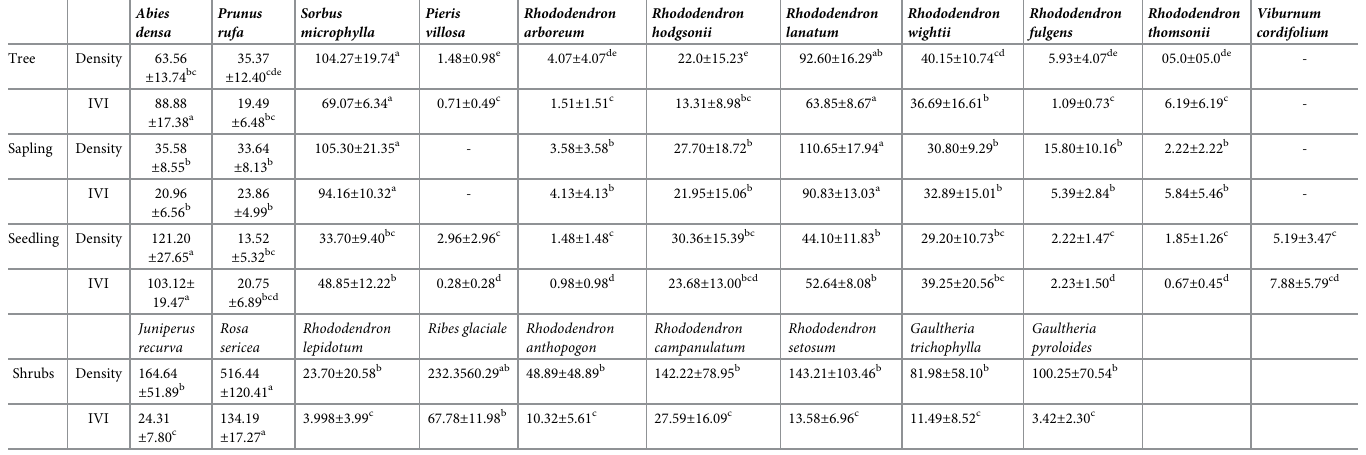
Table 2. Contribution of woody taxa in forest structure of timberline of Dzongri region of Khangchendzonga National Park.